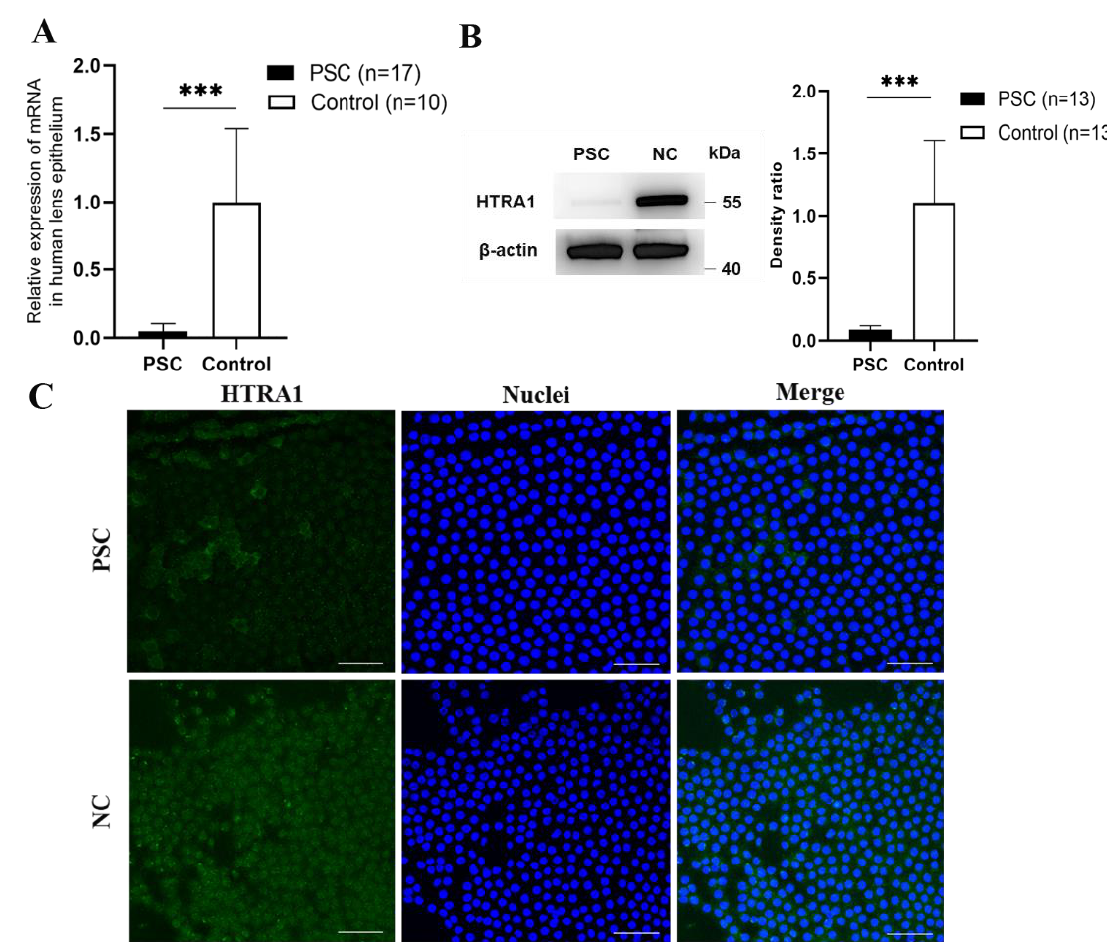
Figure 1. HTRA1 expression downregulated in PSC patients. ( A ) The mRNA level of HTRA1 in anterior lens capsules based on RT-qPCR analyses ( p < 0.01). ( B ) The protein levels of HTRA1 in anterior lens capsules based on Western blotting ( p < 0.001). ( C ) Immunofluorescence images of HTRA1 staining in anterior lens capsules ( n = 3). *** p < 0.001, Scale bar: 20 μm.